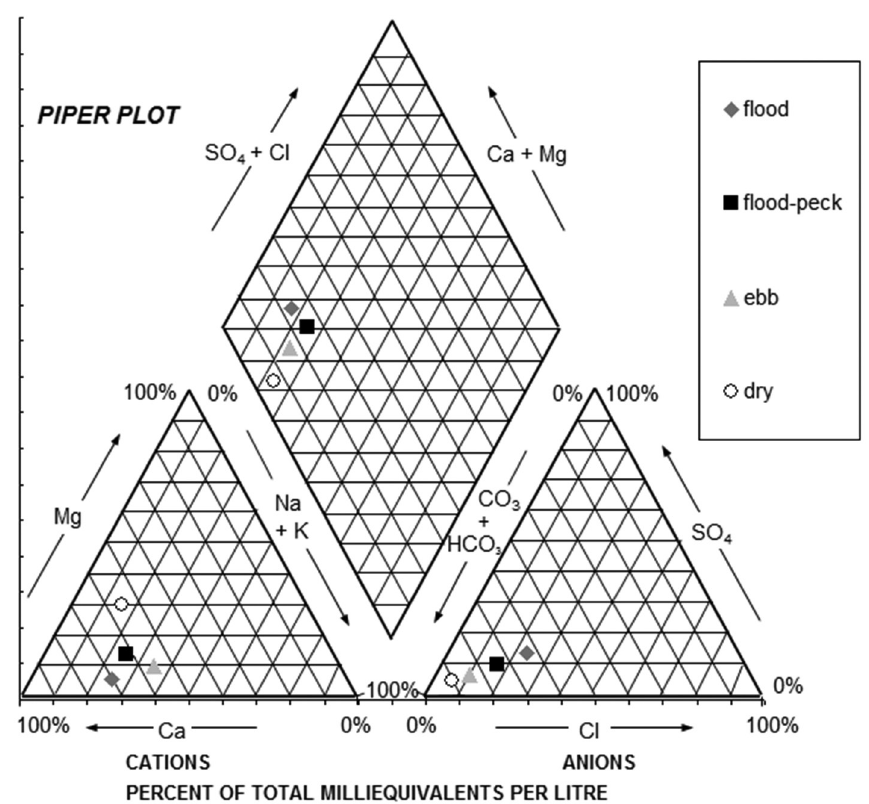
Figure 4. Ionic balance for the Catalão Lake’s waters under the influence of Negro (black waters) and Solimões (white waters) rivers with data identifying the periods of the seasonal flood